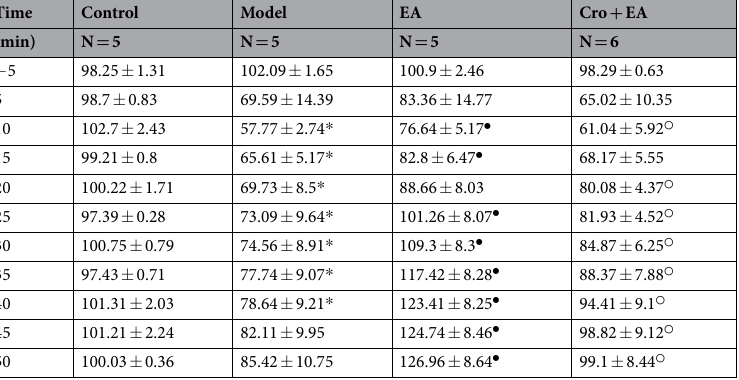
Table 2. Comparison of the relative blood pressures among the groups (AVG ± SEM, n = 5–6). * P < 0.05, Control vs. Model; ● P < 0.05, Model vs. EA; ○ P < 0.05, Cro + EA vs.